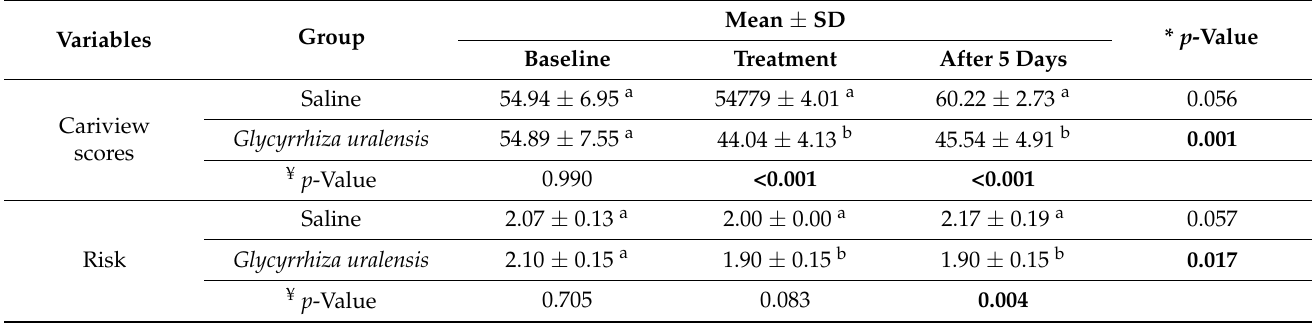
Table 3. Changes in the Cariview scores of the two groups.